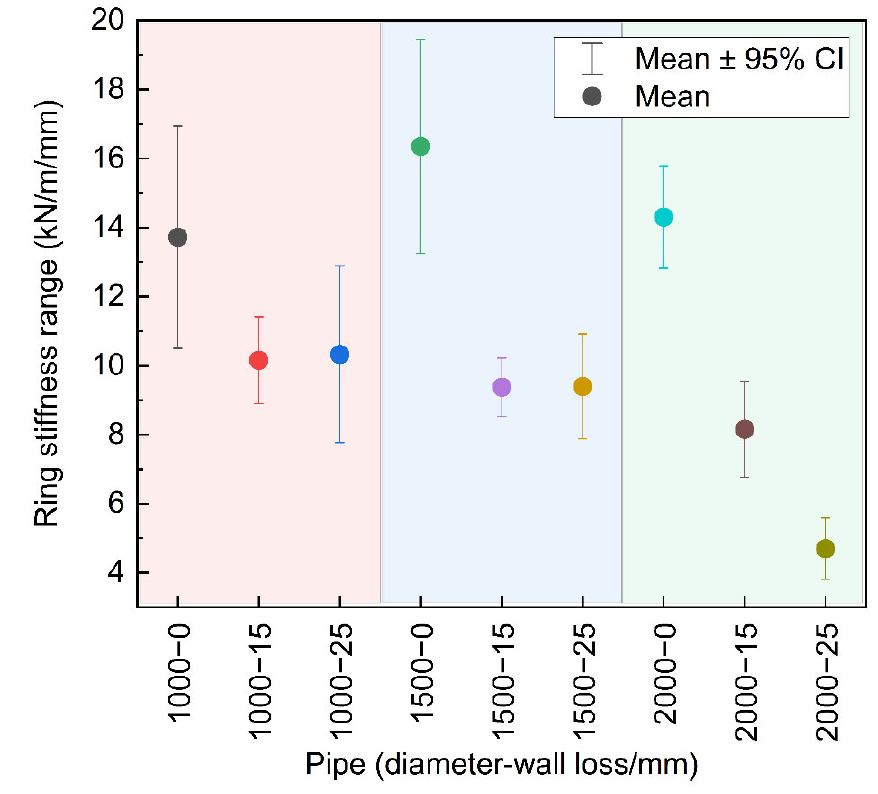
Figure 14. 95% CI for the mean of ring stiffness for concrete pipes.